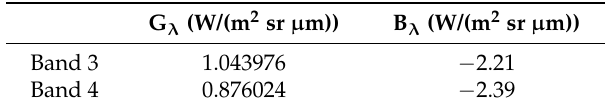
Table 2. The band-specific rescaling factors for Landsat 5′s band 3 and band 4.